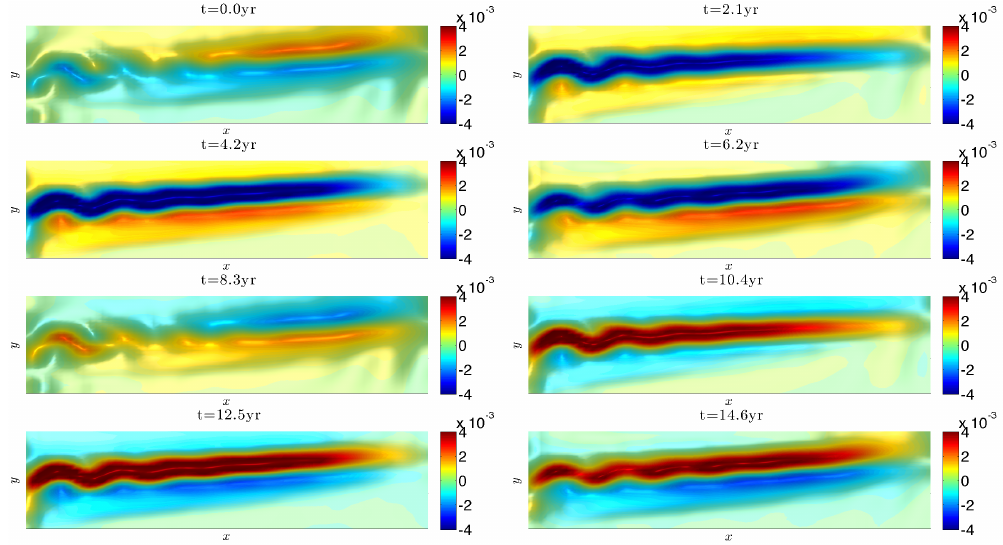
Figure 5. Manifestation in the physical domain of the leading pair of DAHMs (see Figure 3) at the decadal variability f = 0.061 y − 1 ; i.e., corresponding to the largest | λ j | (top cyan dot) in Figure 2. The resulting pattern is periodic (with period ≈ 16.39 y ). Here, eight oscillation phases labeled by time are